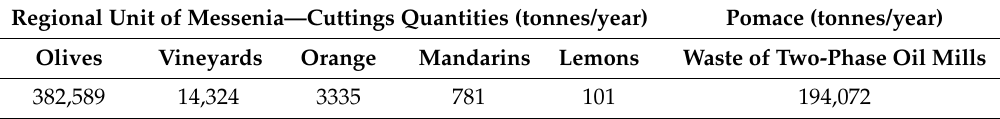
Table 7. Quantities of agricultural waste (in tonnes/year, 2007)